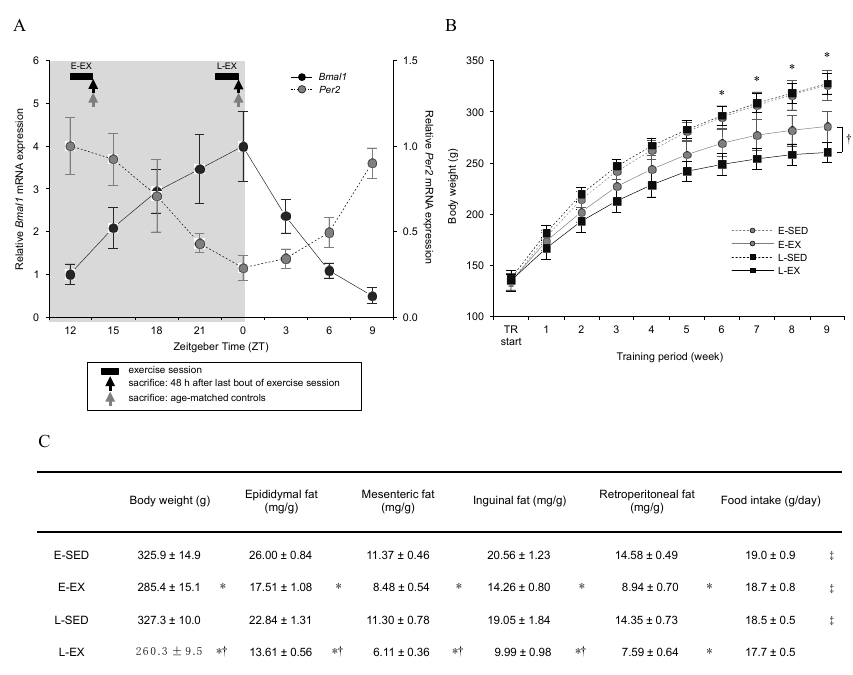
Figure 3. ( A ) Circadian oscillations in Bmal1 and Per2 expression patterns in epididymal adipose tissue and the sampling time. Epididymal adipose tissue was harvested from 5-week-old Wistar rats every 3 h over a 24-h period (eight time points, n = 3 in each time point). Total RNA was extracted from the collected epididymal adipose tissue and the expression levels of Bmal1 and Per2 mRNA were measured by quantitative real-time PCR and normalized to 18S rRNA levels. The values are shown as the means ± S.E. ( B , C ) Effect of exercise training timing on several physical parameters and food intake. The panel B shows changes in body weight during the study period, and table C shows the body weight and the weight of several fat pads at the end of the study, and the mean food intake during the study period. Body weights were measured every week in the morning. Exercise training-induced slowing of body weight gain was observed after six weeks of training time in both training groups compared to that in the control groups ( n = 6 per group): E-EX, exercise in the early part of the active phase; L-EX, exercise performed in the late part of the active phase; E-SED, sedentary control for E-EX; L-SED, sedentary control for L-EX. The values are shown as the means ± S.E. * p < 0.05, SED vs. EX; † p < 0.05, E-EX vs. L-EX; ‡ p < 0.05, vs. L-EX.